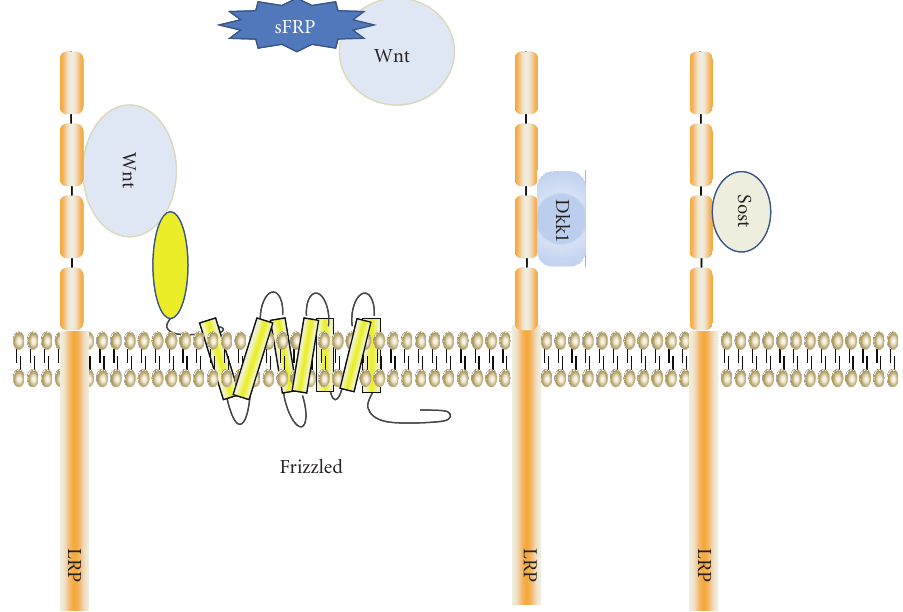
Figure 1: The current model for the induction of stabilization of β -catenin by Wnt ligands holds that Wnt proteins bind a complex that includes a member of the frizzled family of seven-transmembrane-spanning receptors and either LRP6 or LRP5. Several proteins have been identified that can block this process and are associated with downregulation of Wnt signaling. These include proteins which bind to the LRP component to prevent association of Wnt ligands with the LRPs (Dkk1 and Sost). In addition, secreted frizzled related proteins (sFRPs) also can block signaling by binding directly to Wnt ligands and potentially interfering with their ability to engage the receptor complex.